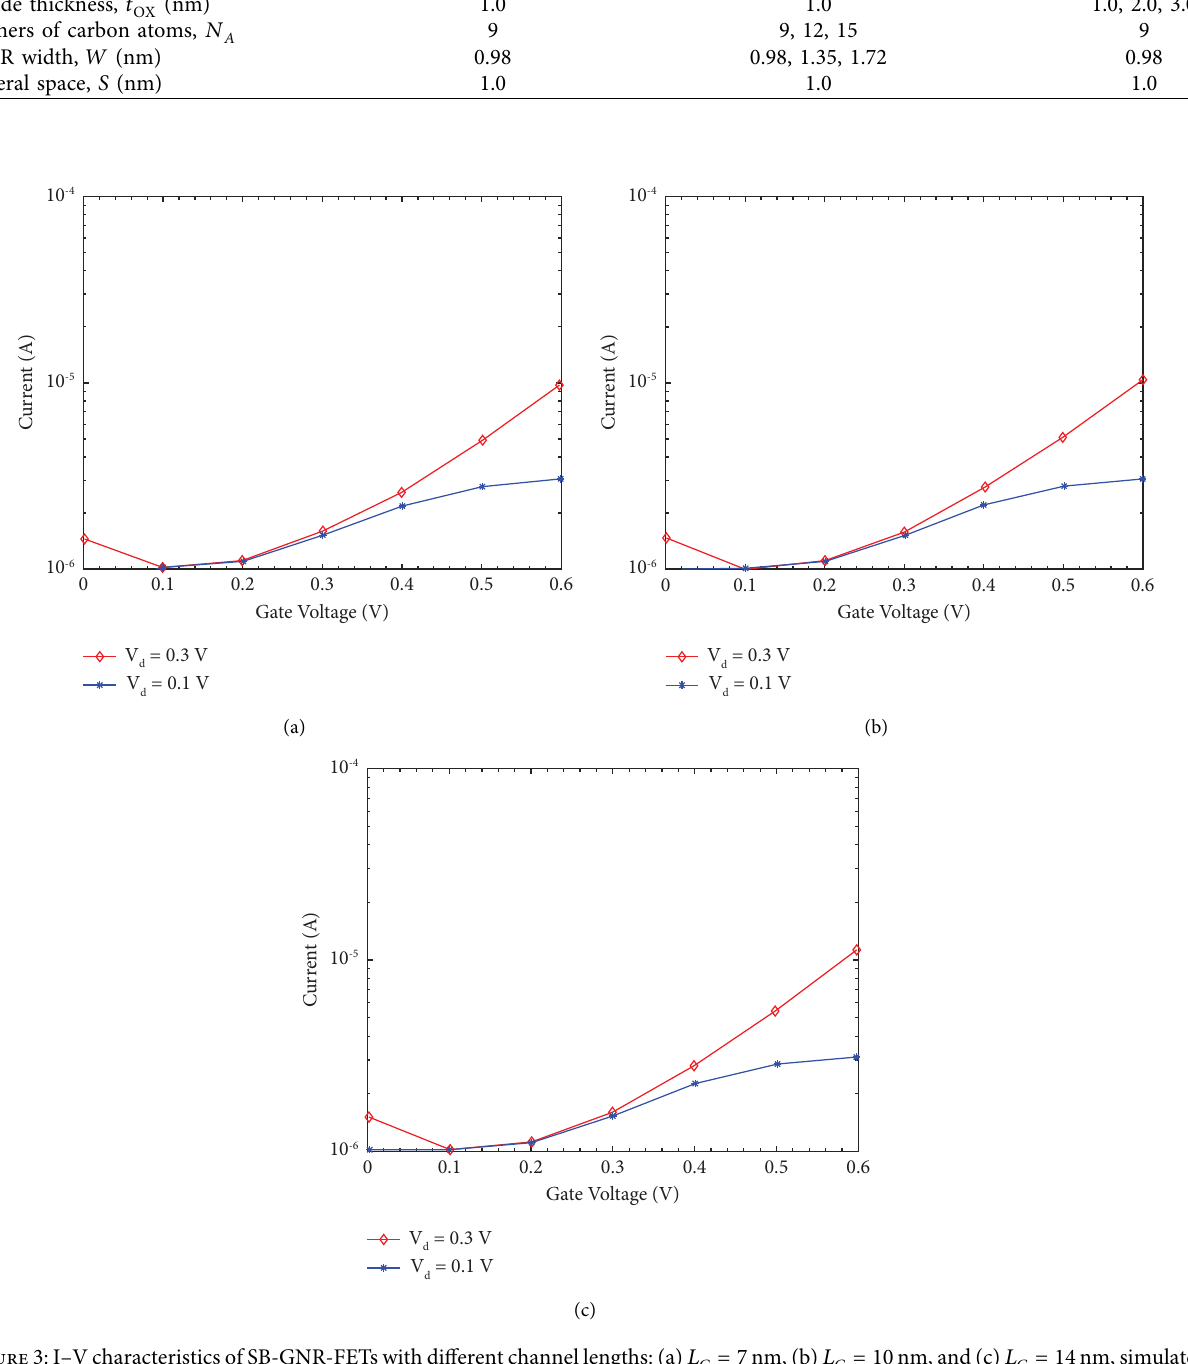
� 7nm, (b) L � 10nm, and (c) L � 14nm, simulated C C C